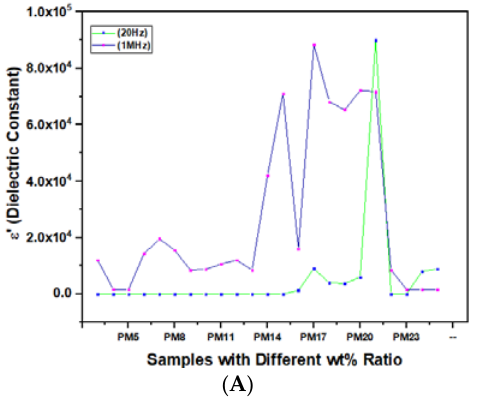
Figure-8. Variation in ( A ) dielectric loss ‘tanδ’ and ( B ) electric modulus ‘M′ of different polymer composite samples at low (20 Hz) and high (1 MHz) frequencies. The spectra of σ’ represents that the values are relatively high at frequency 20 Hz, whereas the values reduce for higher frequencies (up to 1 MHz frequency) due to fast ion oscillation. It is also observed that ac conductivity is increased due to high conduction for frequency raised from 20 Hz to 1 MHz. From the graphs in Figure 7A,B, it is said that the dielectric properties of TiO 2 doped multifunctional polymer NCs has nonlinear behavior. However, ZnO dispersed matrix composites named as high-performance flexible nano dielectrics with high value in die- lectrics constant and improved conductivity at low frequencies (20 Hz), which are used in multifunctional microelectronic devices [75–80]. Significantly enhanced dielectric prop- erties and ‘chain segmental dynamics’ were observed in SnO 2 doped NCs [20]. Material permittivity is a static property, whereas conductivity is purely dependent on its dy- namic property, thus to connect relation between these physical quantities a perfect time scale selection is required. Thus, from above graph, it is clear that the magnitudes of the dielectric constant for higher frequencies are low for both the values of the real and im- aginary part of dielectric permittivity. The dielectric constant of the given or selected samples shows the amount of electrical energy that can be stored on applying voltage